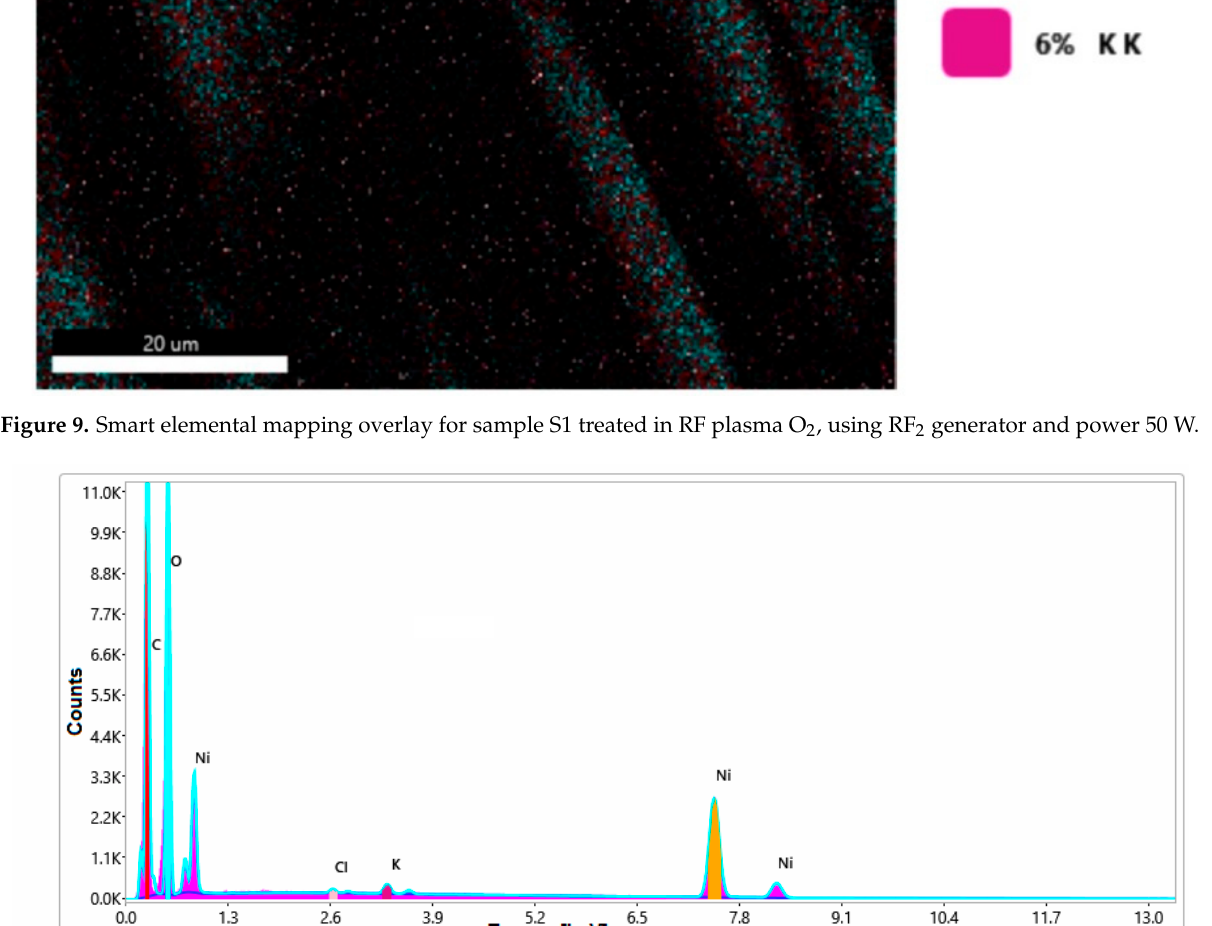
Figure 10. EDS spectra for sample S1 treated in RF plasma O 2 , using RF 2 generator and power 50 W and Ni